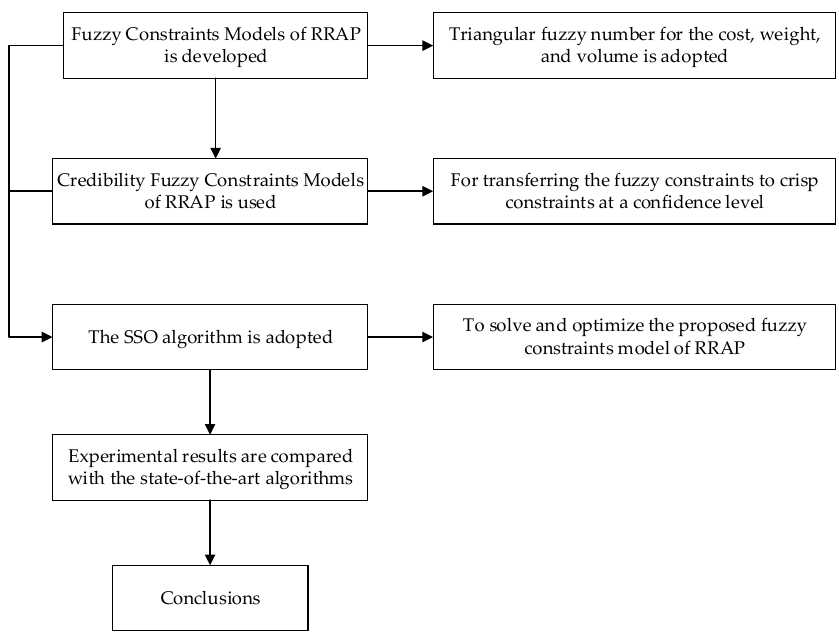
Figure 5. The flowchart of how the system is